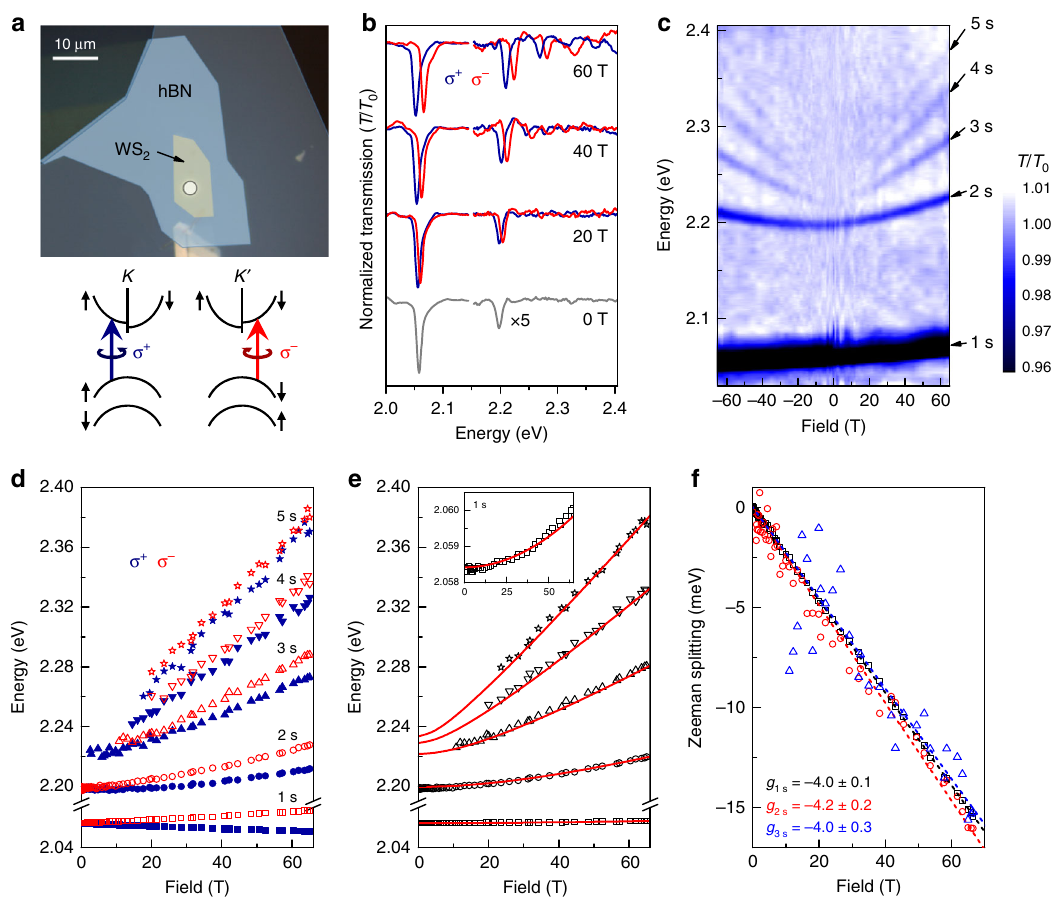
Fig. 1 Magneto-optical spectroscopy of monolayer WS 2 . a Image of a sample/ fi ber assembly: An exfoliated TMD monolayer, sandwiched between hBN slabs, is constructed over the 3 (cid:4) 4 μ m diameter core of a single-mode optical fi ber (white circle). The assembly is mounted in helium exchange gas at 4 K in the bore of a pulsed magnet. The diagram depicts the optical selection rules in the K and K ′ valleys. b Normalized transmission spectra ( T = T 0 ) of monolayer WS 2 at selected magnetic fi elds B = 0, 20, 40, and 60 T. Blue/red curves indicate σ þ / σ (cid:4) circular polarization (optical transitions in the K = K ′ valleys, respectively). c Intensity map of all the transmission spectra, from (cid:4) 65 to þ 65 T. Excellent sample quality allows observation of the 2 s , 3 s , 4 s , and 5 s excited Rydberg states of the neutral A exciton. d Energies of the 1 s (cid:4) 5 s excitons for both σ ± polarizations. e Average energy of the σ ± transitions for ð E þ E Þ , reveals distinct diamagnetic shifts. Solid lines show calculated energies using the Rytova – Keldysh model described in the text. each ns state, 1 σ þ σ (cid:4) 2 ¼ 0 : 175 m r ¼ 3 : 4 nm , κ ¼ 4 : 35, and E ¼ 2 : 238 eV. Inset: Expanded plot of the 1 s exciton energy, showing its small quadratic Parameters: m 0 , 0 r gap diamagnetic shift. f The Zeeman splitting of the 1 s , 2 s , and 3 s exciton states ( E σ þ (cid:4) E σ (cid:4) ); dashed lines depict linear fi